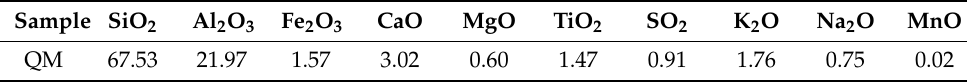
Table 2. Chemical composition of QM coal ash (wt.%) [28].